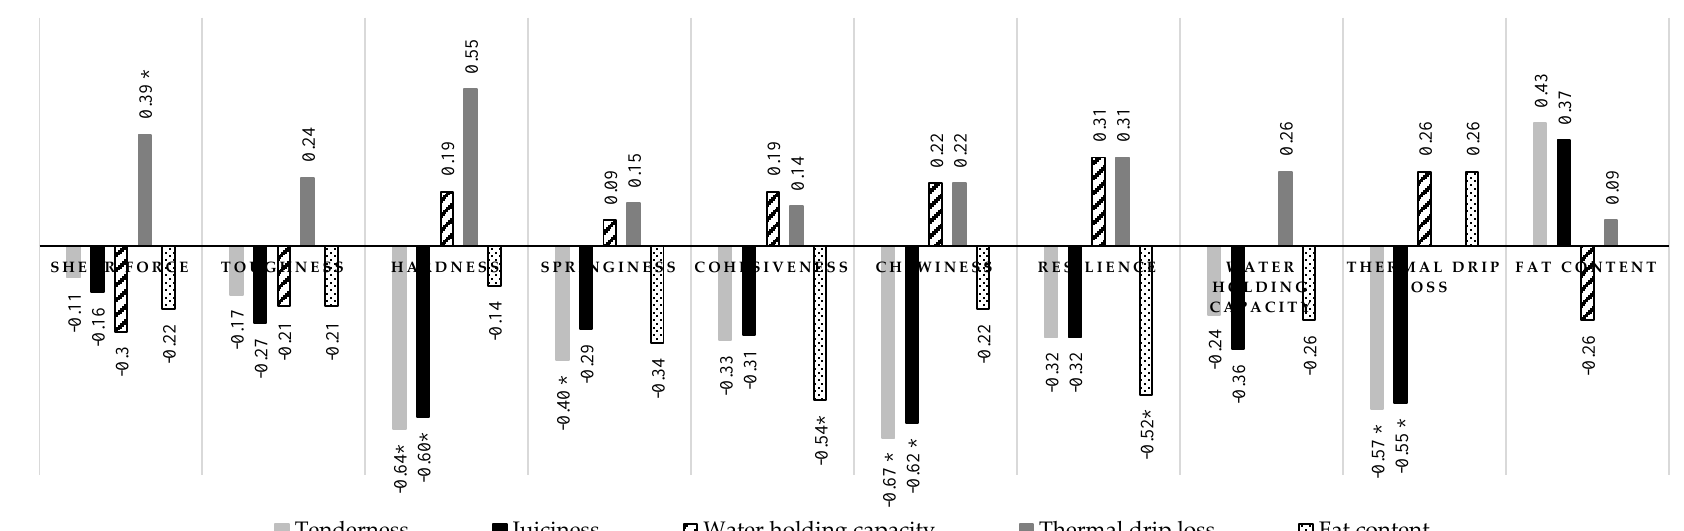
Figure 2. Correlation coefficients for chosen quality traits of meat ( longissimus m.) (* correlation statistically significant at p ≤ 0.05) .